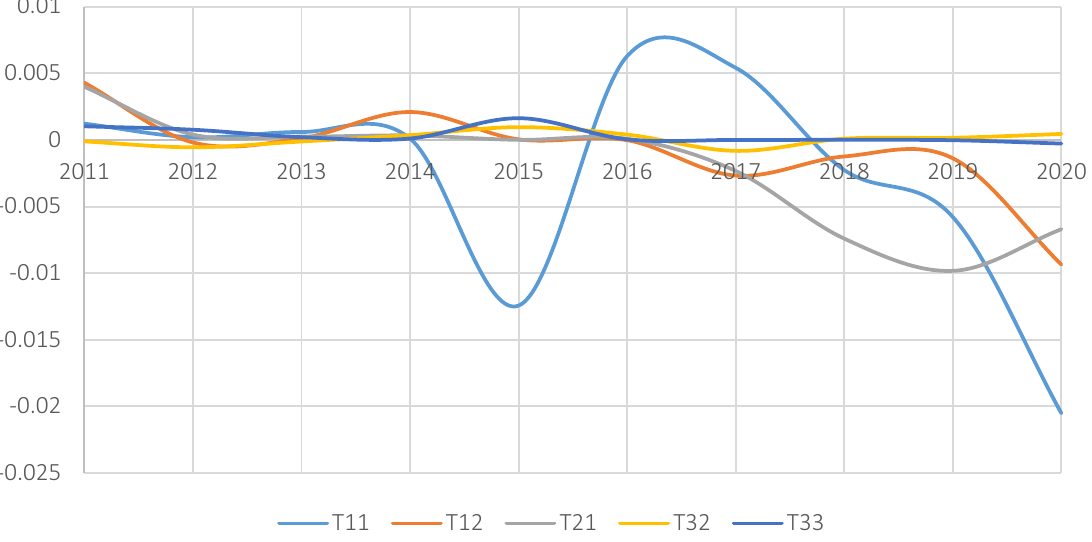
-0 -0 . 02 -0 . 025 Figure 3. Dynamics of average annual entropy production by types of taxes